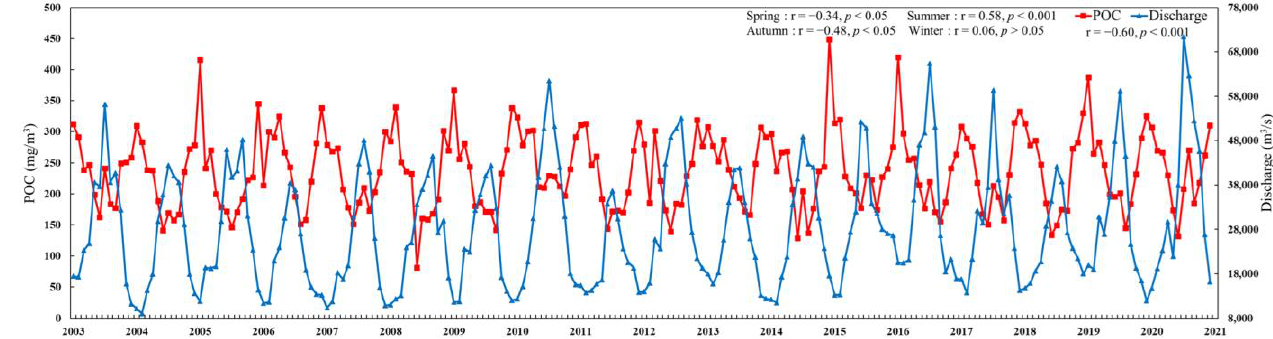
Figure 6. Time series of the monthly mean surface concentration of POC in the East China Sea and the monthly mean discharge of the Changjiang River’s Datong hydrological station from 2003 to 2020.